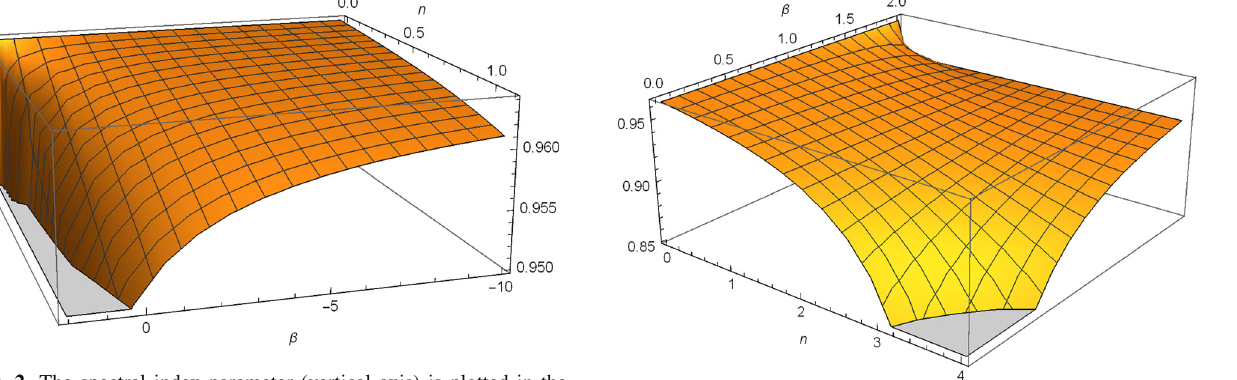
Fig. 2 The spectral index parameter (vertical axis) is plotted in the ranges β = [− 10 , 2 ] , n = [ 0 , 1 . 1 ] with the values γ = 0 . 018, N = 60